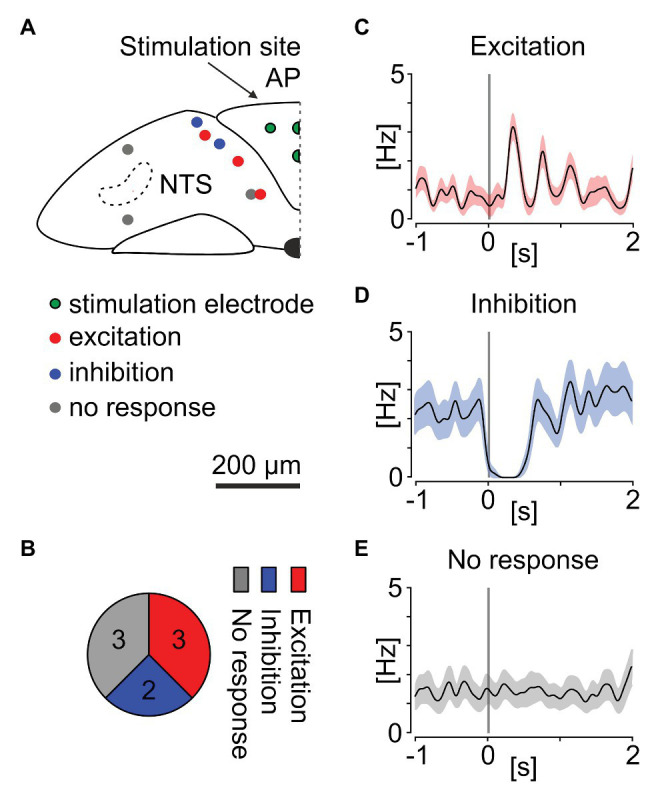
Electrical stimulation of the AP alters neuronal activity of phasic neurons in the mouse NTS. (A) Anatomical reconstruction showing the localisation of the stimulation electrodes in the AP (green circles) and phasic cells in the NTS: excited by the AP stimulation (red), inhibited (blue), or exhibiting no response (grey circles). (B) Pie chart summarising the proportion of responsive cells. (C–E) Mean peri-stimulus firing rate plots showing the spike density of all excited, inhibited, and non-responsive cells before and after the AP stimulation. Gaussian probability was generated with Kernel function (width: 50 ms). Grey bar depicts the stimulation time. Shading codes the average SEM for all responses of all neurons in one group.